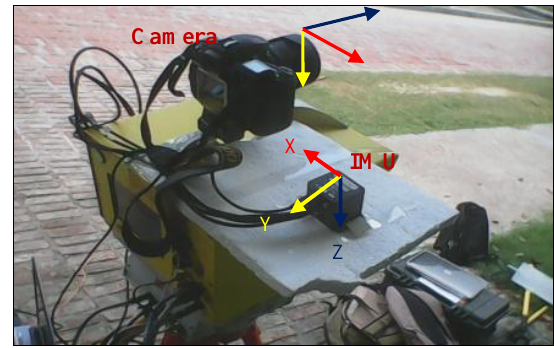
Figure 2. Experimental